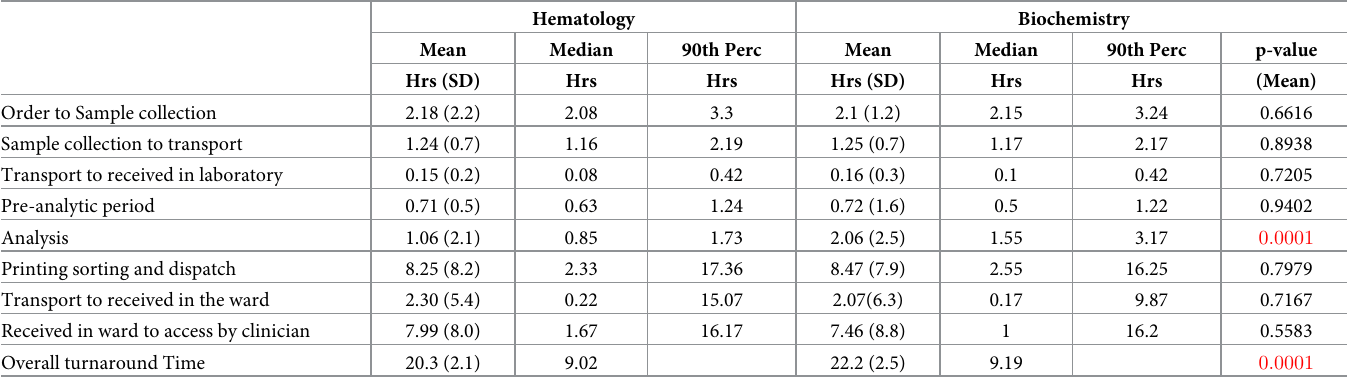
Table 2. Turnaround time for specific time intervals of the workflow process.